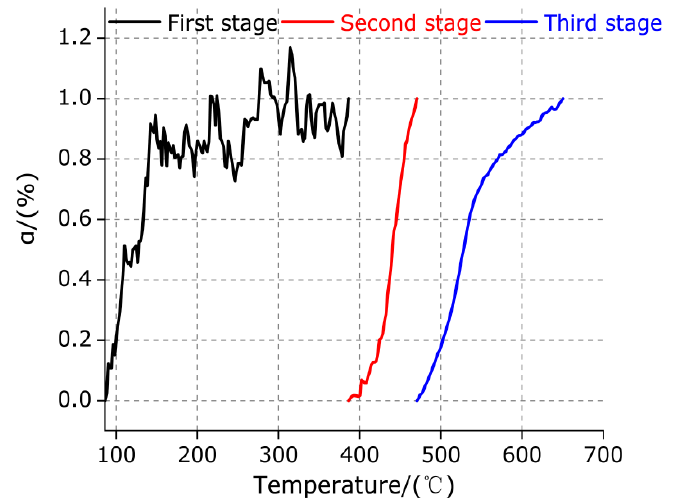
Figure 9. Variation trend of percentage of mass loss ( α ) with temperature in each stage of TiH 2 .